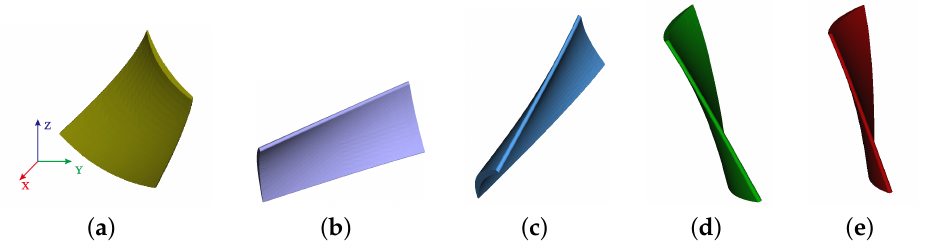
Figure 10. Comparison of candidate build orientation: ( a ) Original model, ( b ) orientation 1, ( c ) orien- tation 2, ( d ) orientation 3, ( e ) orientation determined by EWO method.